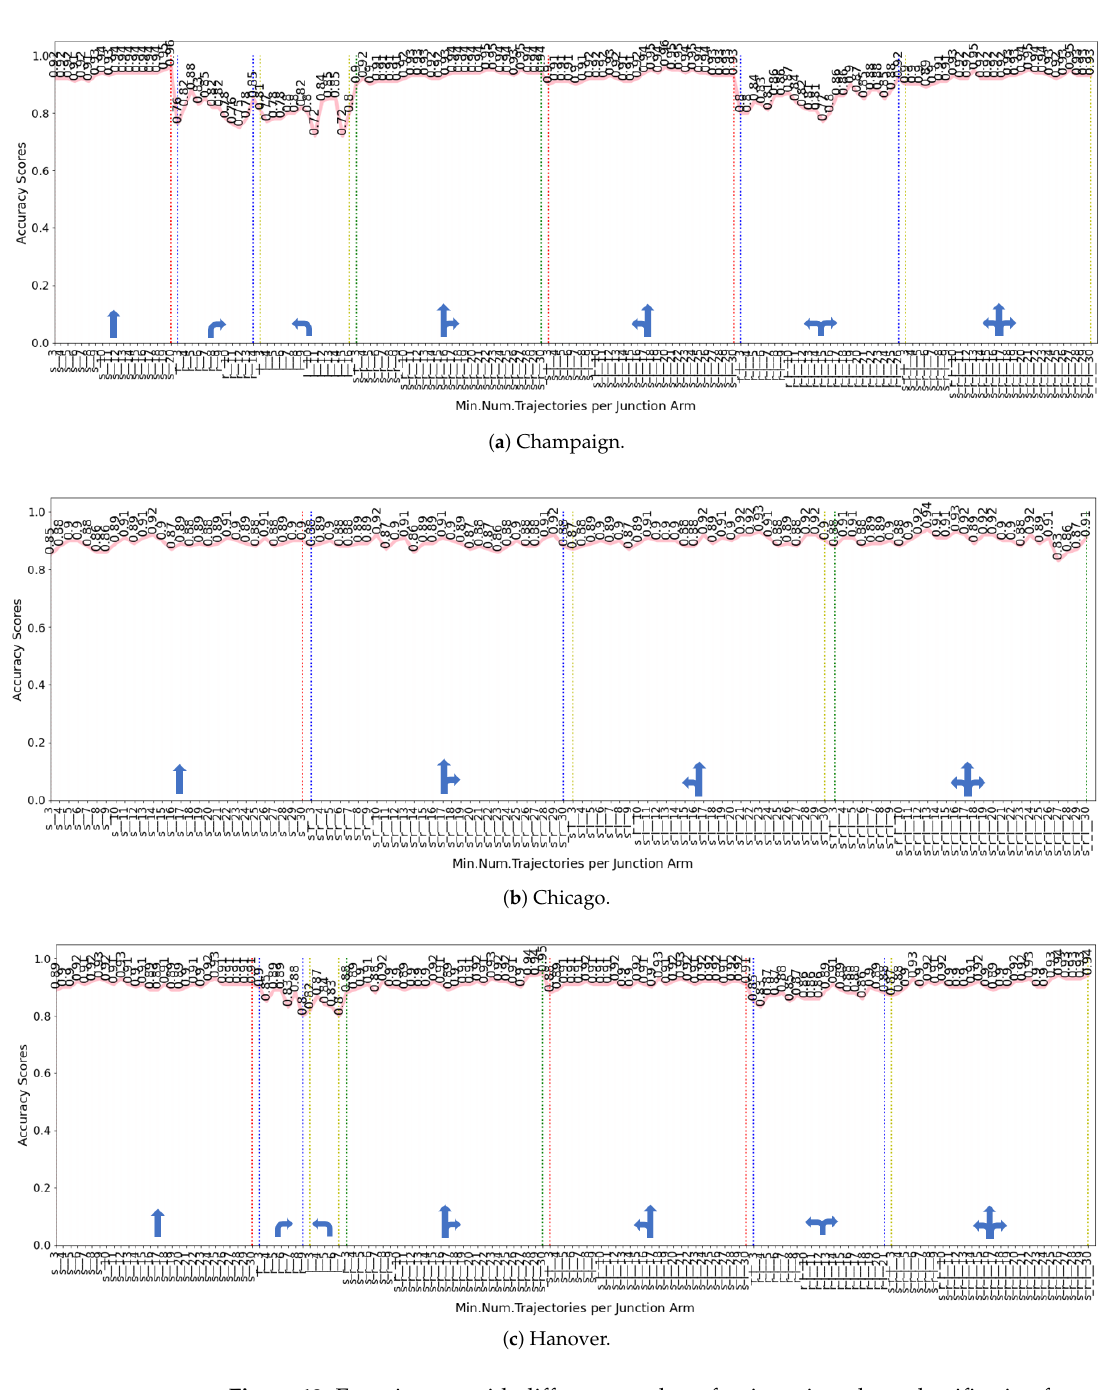
Figure 13. Experiments with different number of trajectories where classification features are com- puted using a certain number of trajectories, i.e., 3, 4, ..., and not all available crossing